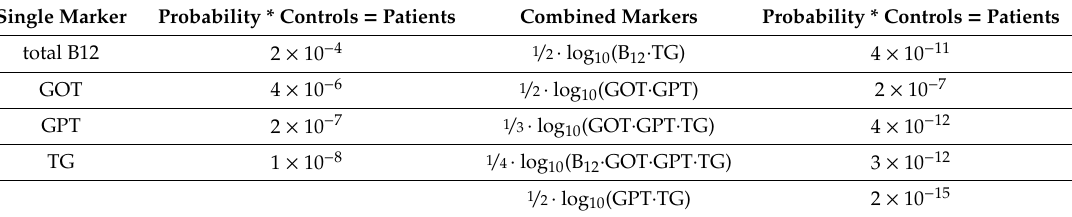
Table 5. E ff ectiveness of single and combined markers in discriminating controls from GSD patients. Single